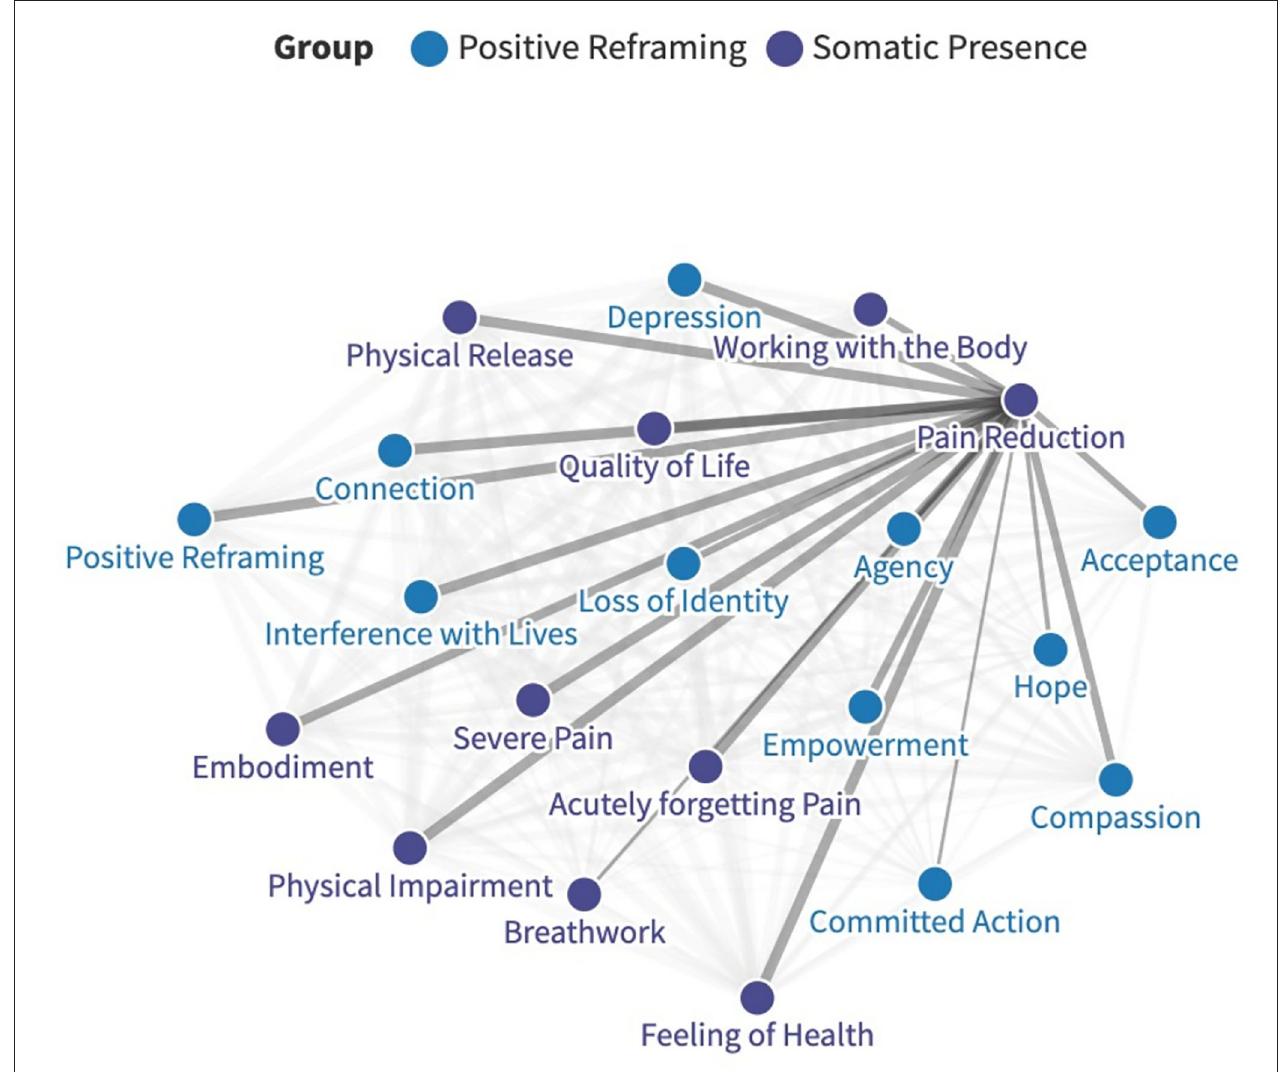
FIGURE 1 | An example of how relative connection strengths were mapped on a network graph, in this case regarding pain reduction. The full, interactive graph is available here: